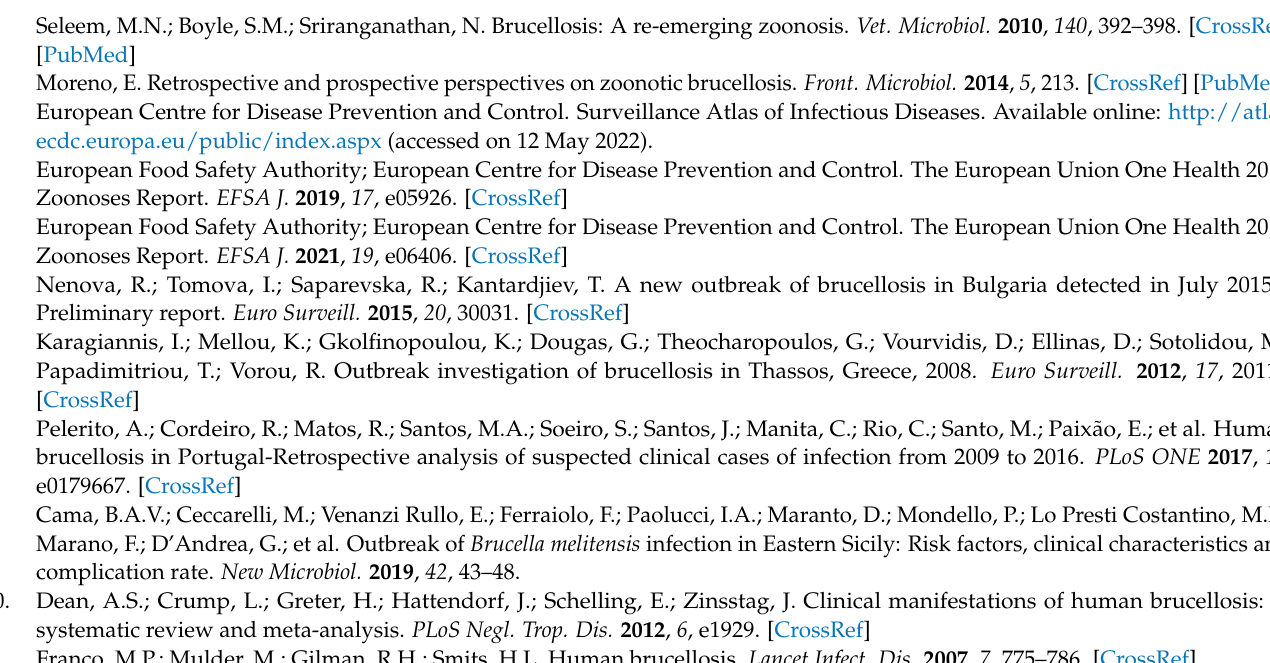
Figure S2: Growth curve of Bm150048 in two different culture media (BB, CAMHB). Table S2: Com- parison of BMD and AD using two different culture media (BB, CAMHB). Figure S3: Impact of the incubation time on the MIC values. Table S3: Impact of the cultivation atmosphere on the MIC